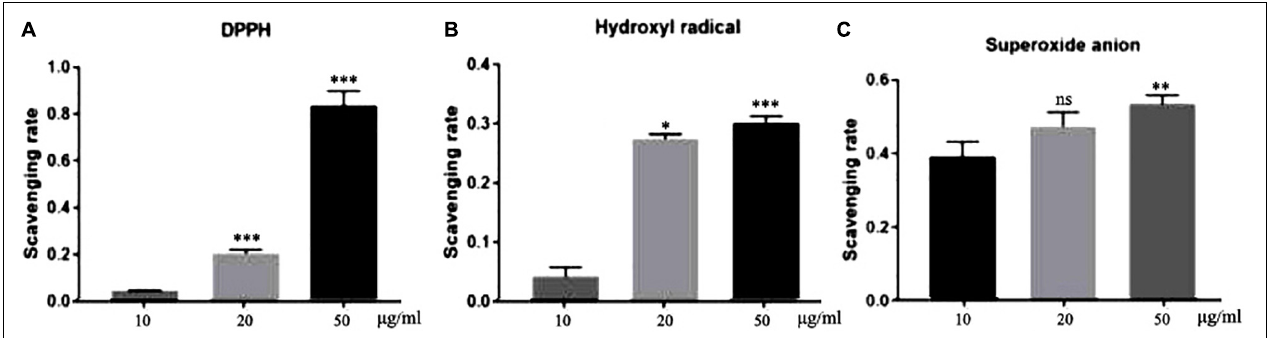
FIGURE 1 | In vitro antioxidant potential of TFH. Results are represented as mean ± SEM of three independent replicates. ns, no significance; *** p < 0.001, ** p < 0.01, * p < 0.05 vs. the 10 µ g/ml group.